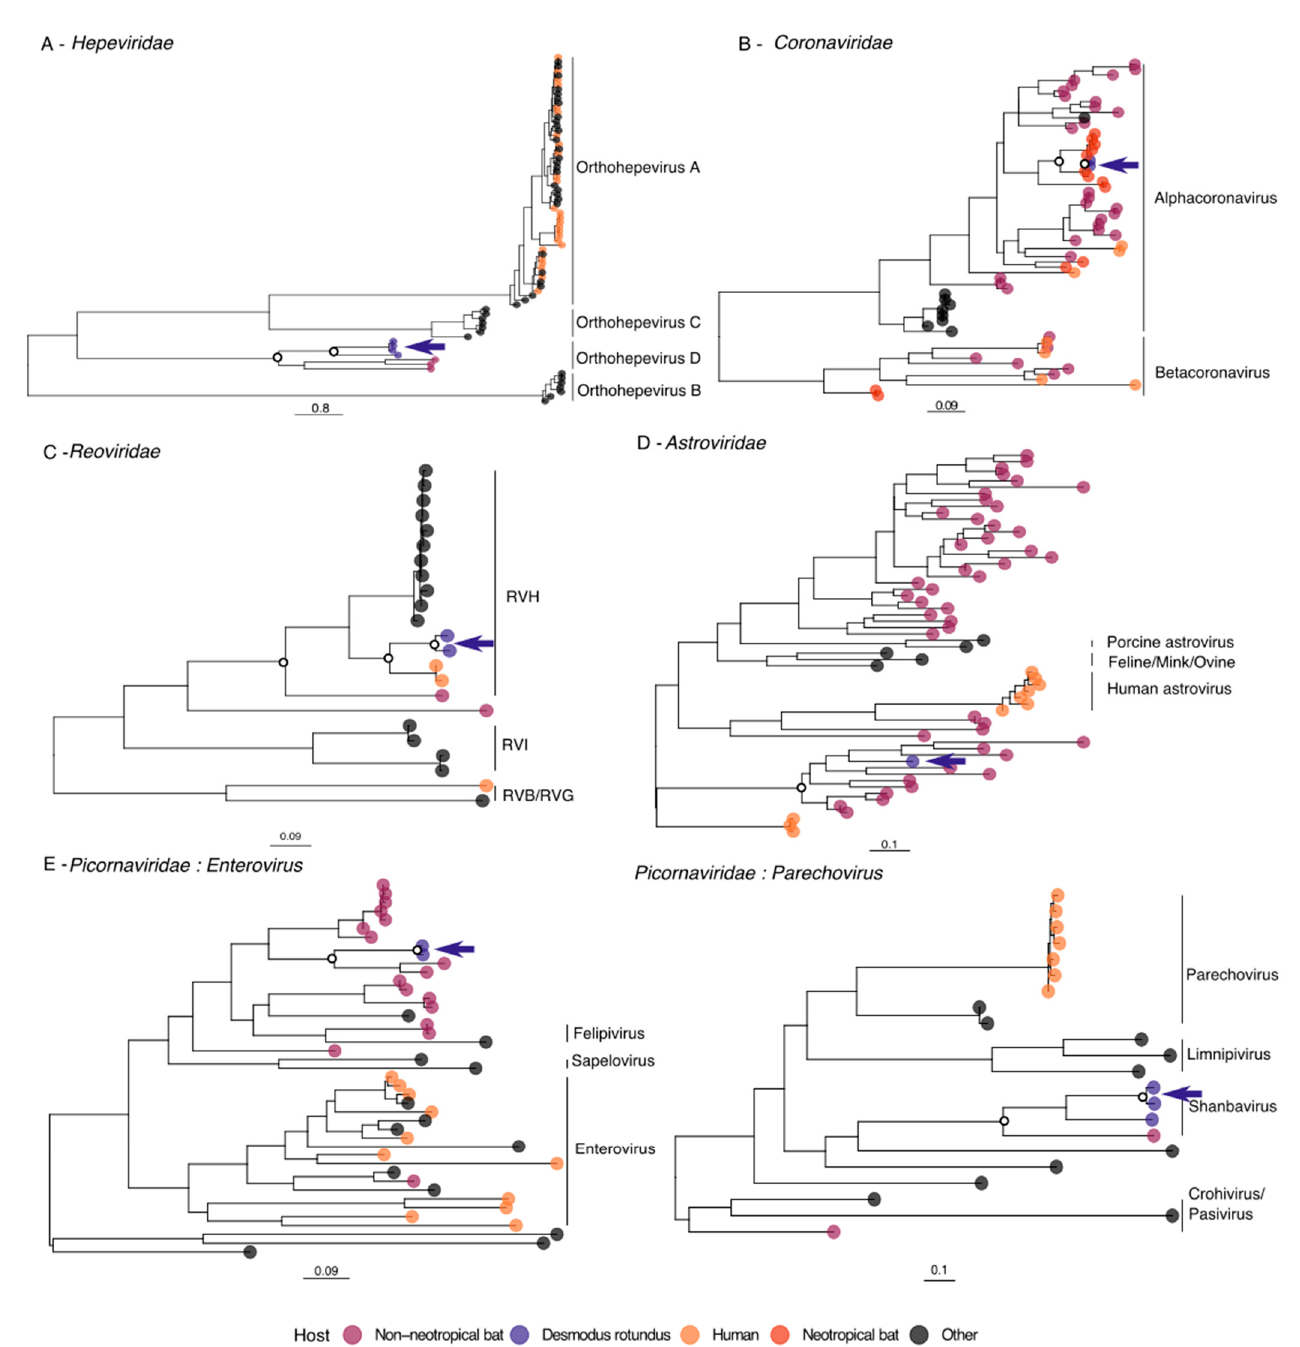
Figure 2. Phylogenetic placement of novel vampire bat viruses. Maximum likelihood phylogenies show relationships of vampire bat viruses (indigo) with previously described viruses from five different families. Two separate phylogenetic analyses were performed for Enterovirus -like and Parechovirus -like viruses in the family Picornaviridae . International Committee on Taxonomy of Viruses (ICTV) recognized viral species or genera are shown on the right side of trees; some Rotavirus taxa are not yet officially recognized, but are shown to provide context for new sequences. Bootstrap support values >90 are shown as white circles for key nodes. Arrows indicate vampire bat viruses. The scale bar represents the mean number of substitutions per site. Detailed versions of each phylogeny including node support and Genbank accessions for published sequences are shown in Figures S2–S7.